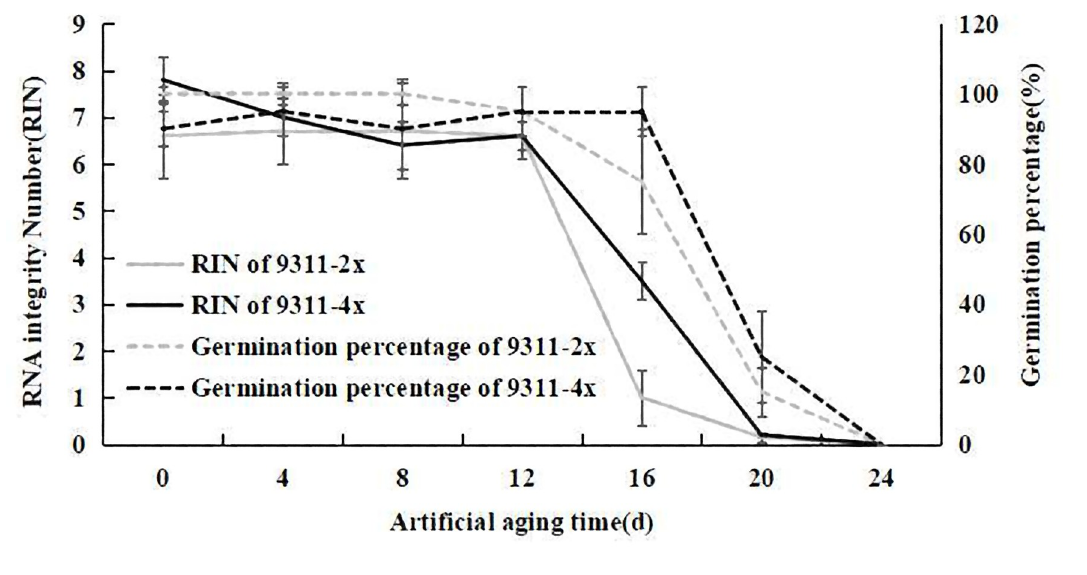
Fig 3. RNA quality and germination rate of 9311-2x and 9311-4x seed aged for up to 24 days at 45˚C and 85% RH. RNA quality is expressed as RIN (solid line, error bars are the standard deviation) of 9311-4x (dark color) and 9311-2x (light color). Germination rate is presented as broken lines for 9311-2x (light color) and 9311-4x (dark color). Values were the mean ± SE.